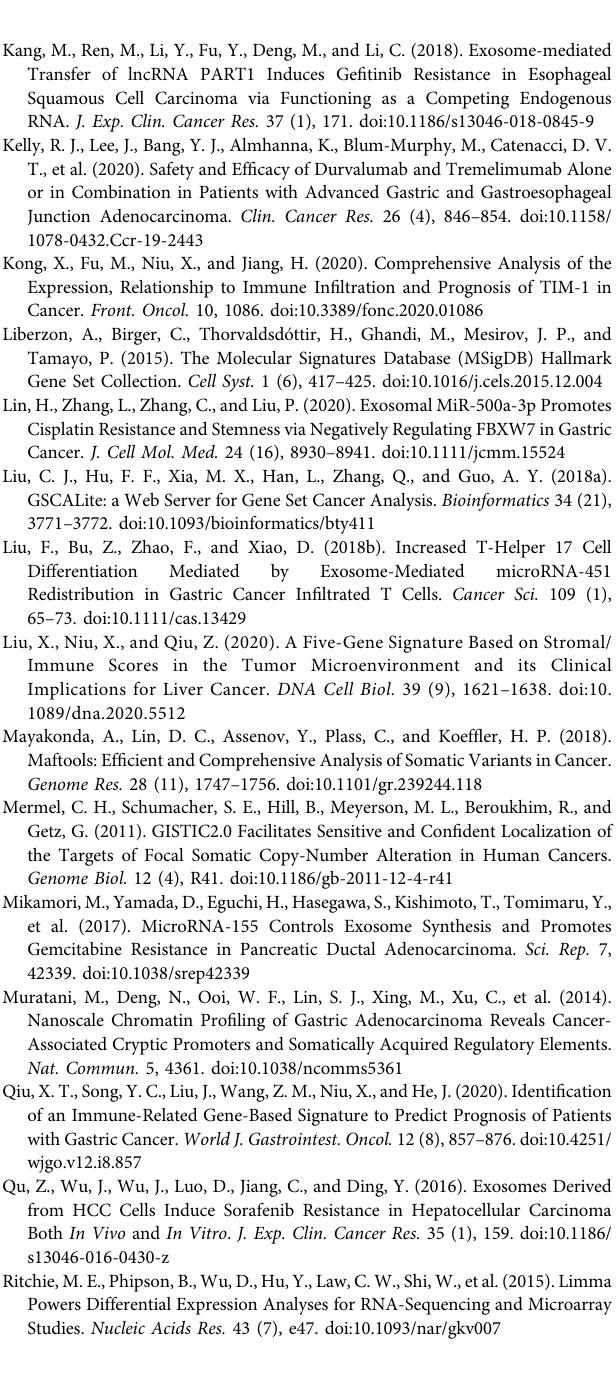
expression of genes that made up the signature (lower). (B) Kaplan – Meier curves of OS in the GSE15459 cohort, separated into high- and low-risk groups. (C) Time-independent ROC curves showing the prediction accuracy of the model. Supplementary Table S1 | List of exosome-related